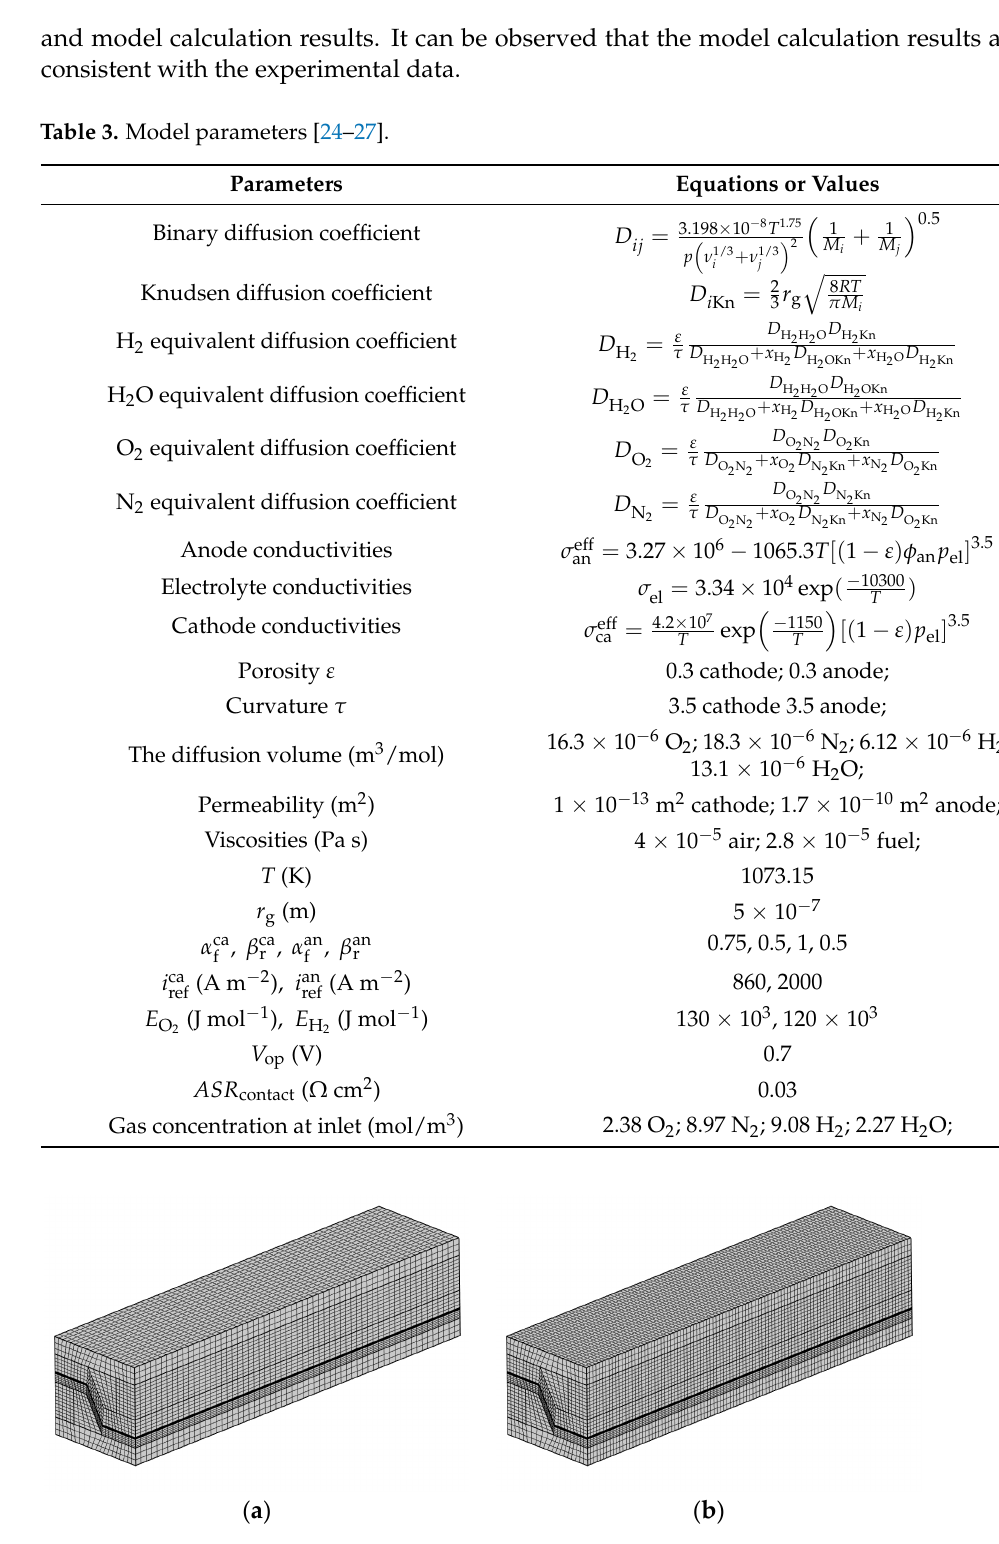
Figure 3. Model validation [24]. Table 3. Model parameters [24–27]. Parameters